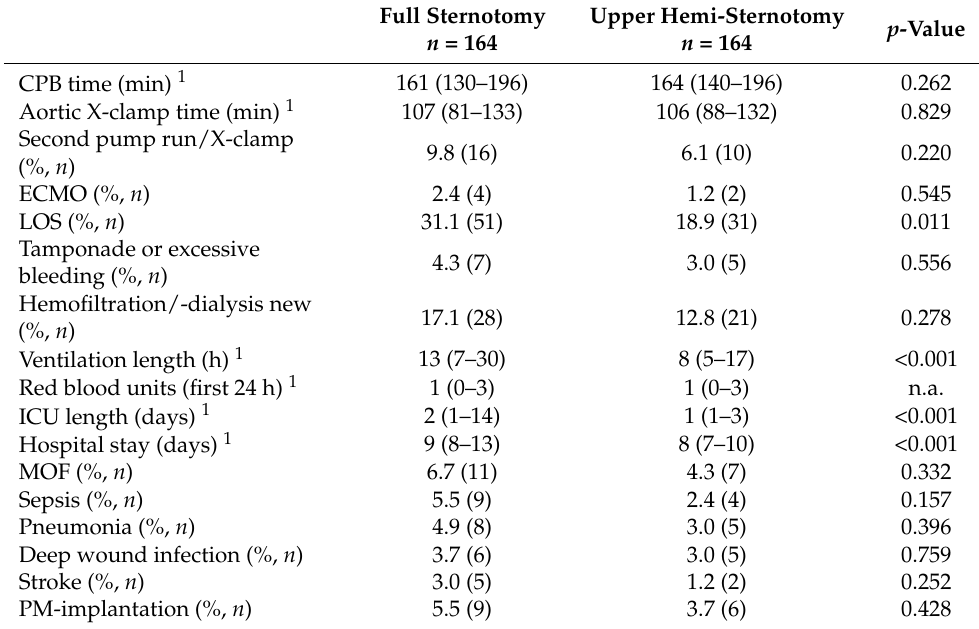
Table 3. Secondary intra- and postoperative endpoints in the propensity score matched